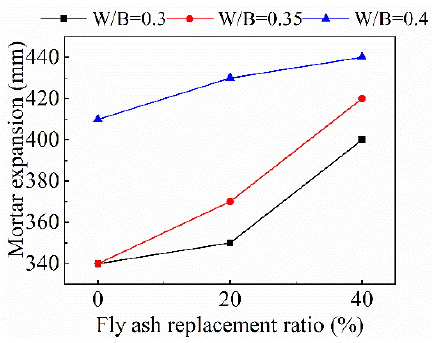
Figure 4. Variation of expansion with fly ash replacement ratio.